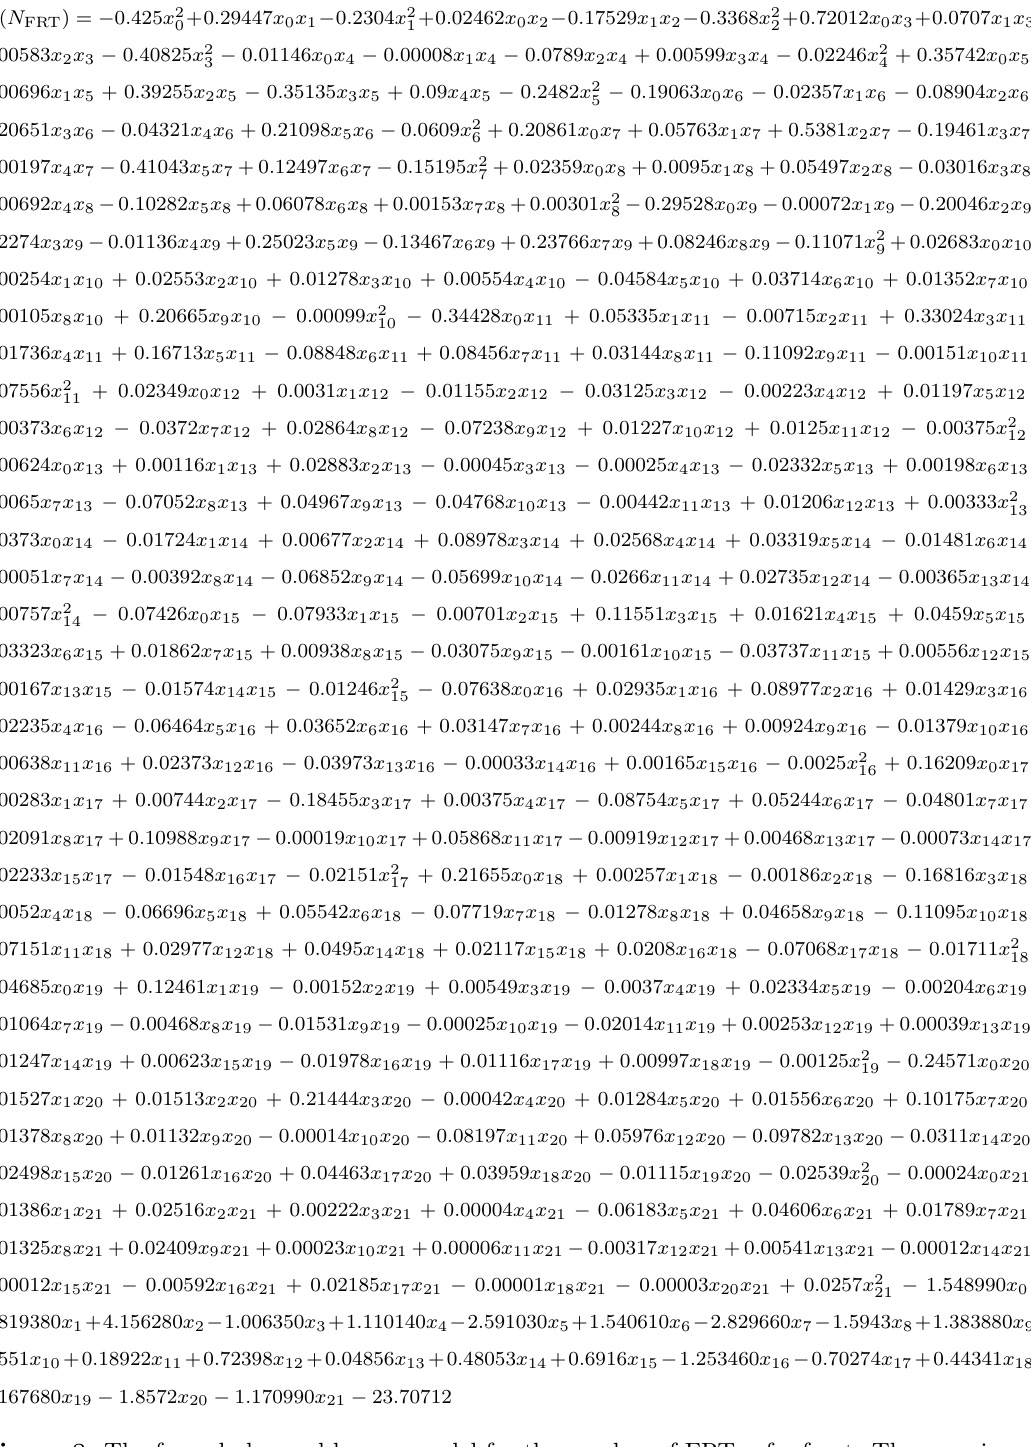
Figure 8 . The formula learned by our model for the number of FRTs of a facet. The meanings of the x i are described in section